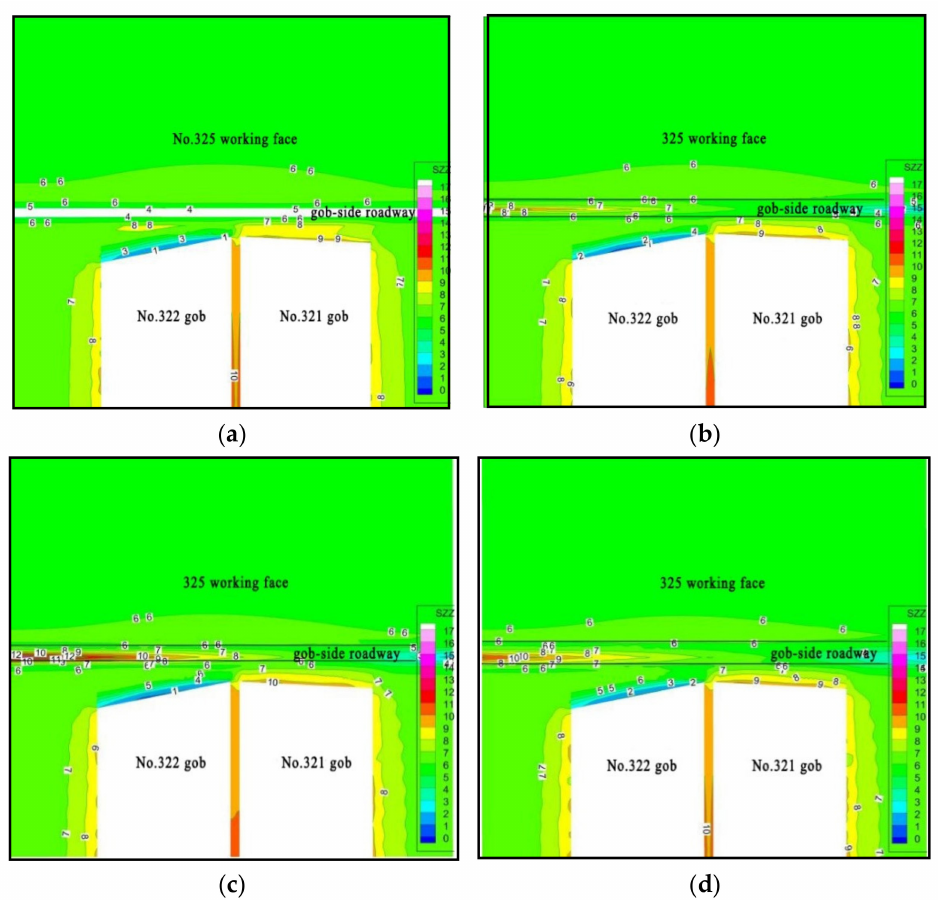
Figure 9. “Umbrella” coal pillars along the goaf roadway roof’s vertical stress plan: ( a ) roadway waist line; ( b ) roadway roof (0.5 m); ( c ) roadway roof (1.5 m); ( d ) roadway roof (2.5